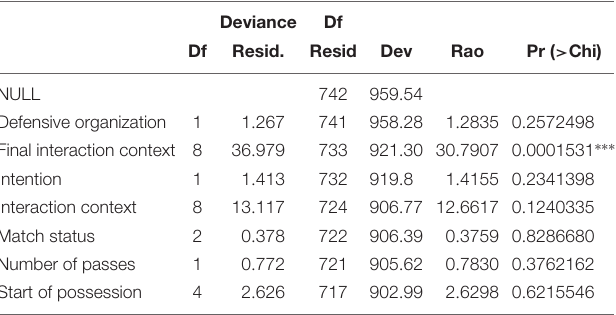
TABLE 3 | Analysis of deviance